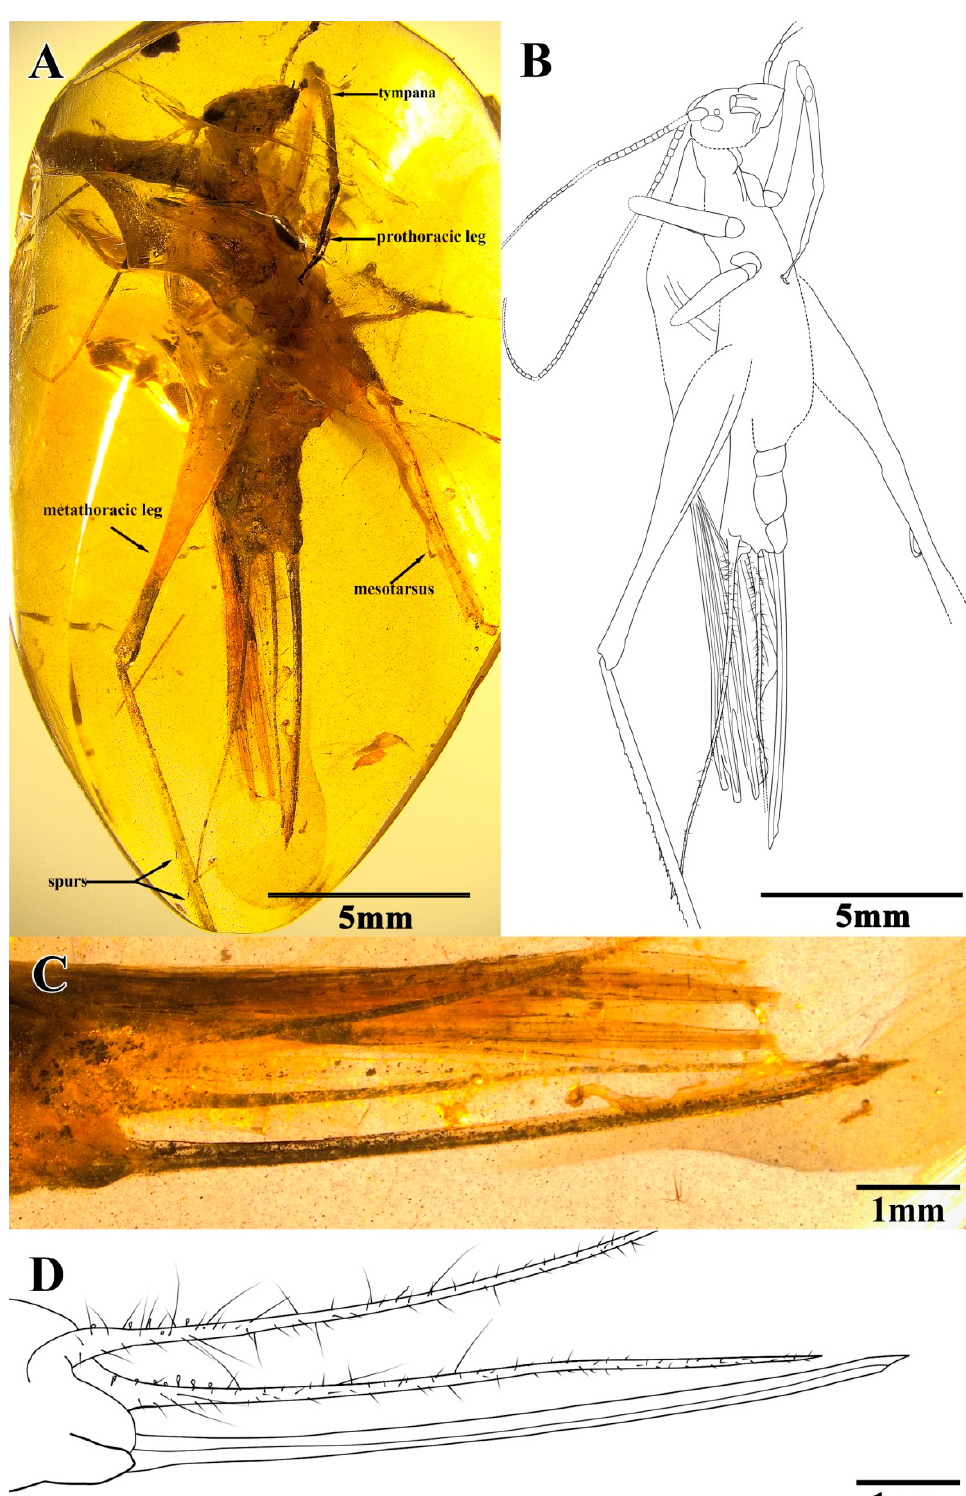
Figure 3. A. cretaceus sp. nov.: ( A ) photograph of lateral view, ( B ) line drawing of lateral view, ( C ) photograph of ovipositor, and ( D ) line drawing of ovipositor. Etymology: After the Cretaceous Period. Diagnosis. The protibia had small oval tympana on both sides and was apically armed with one visible spur; the probasitarsus was slender and slightly shorter than the